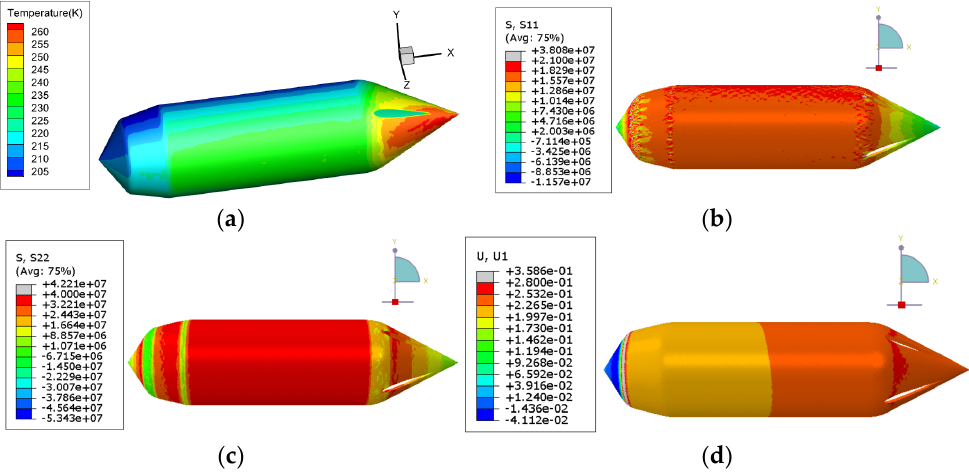
Figure 9. Simulation results at 6:00 p.m. ( a ) Temperature distribution at 6:00 p.m. ( b ) S11 stresses at 6:00 p.m. (units: Pa) ( c ) S22 stresses at 6:00 p.m. (units: Pa) ( d ) U1 deformation at 6:00 p.m. (units: